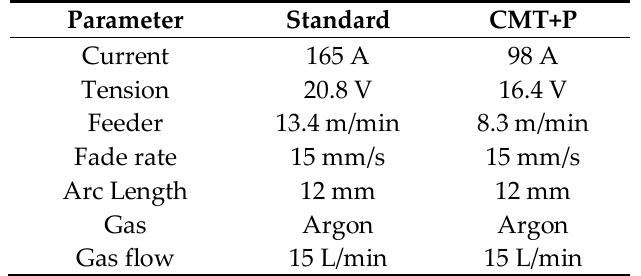
Table 1. Main welding parameters for the implemented experimental